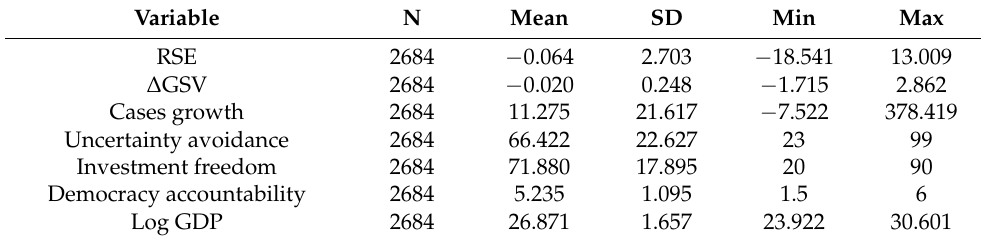
Table 1. Summary